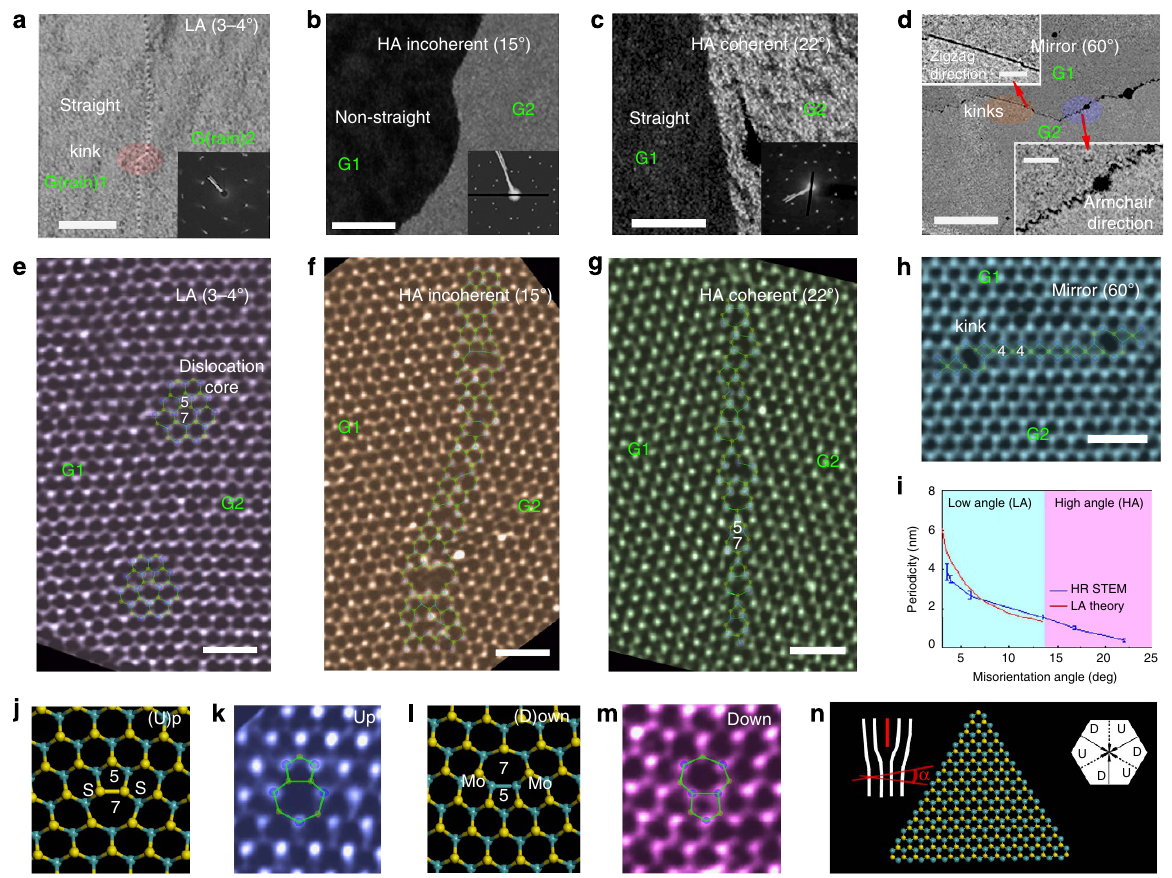
Figure 2 | TEM characterization of the MoS 2 GBs showing misorientation angle dependence. ( a – d ) DF-TEM images of low-angle (3-4 (cid:2) ), high-angle incoherent (15 (cid:2) )/coherent (22 (cid:2) ) and mirror GBs (60 (cid:2) ); scale bar, 50nm. The insets in ( a - c ) show SAED patterns of the GBs, while the two inset images in ( d ) display zigzag (upper part) and armchair direction (lower part) mirror GBs. The scale bars in the latter two insets are 20nm. ( e – h ) High-resolution ADF-STEM images correlated to the four cases presented in ( a – d ); false colour was applied. Scale bar, 1nm. The dislocation cores and GBs were superimposed with atomistic models; blue and yellow circles denote Mo and S atoms, respectively, while the two domains are marked as G1 and G2. ( i ) Experimentally measured periodicity of the dislocation cores vs. misorientation angle with LA theory fitting. ( j – m ) Two types of LA-GBs: ‘Up’ type (S-S bond) and ‘Down’ type (Mo-Mo bond) (5-7) dislocation cores. The DFT-optimized models for each dislocation type are shown in ( j , l ), while ADF images superimposed with atomistic models are displayed in ( k , m ). ( n ) Atomistic model for a triangular flake with Mo-terminated zigzag edges, the upper left inset shows the ‘Up’ type dislocation scheme, while the upper right inset shows the six armchair directions in MoS 2 with either ‘Up’ or ‘Down’ type dislocations. The directions of all schemes are correlated and